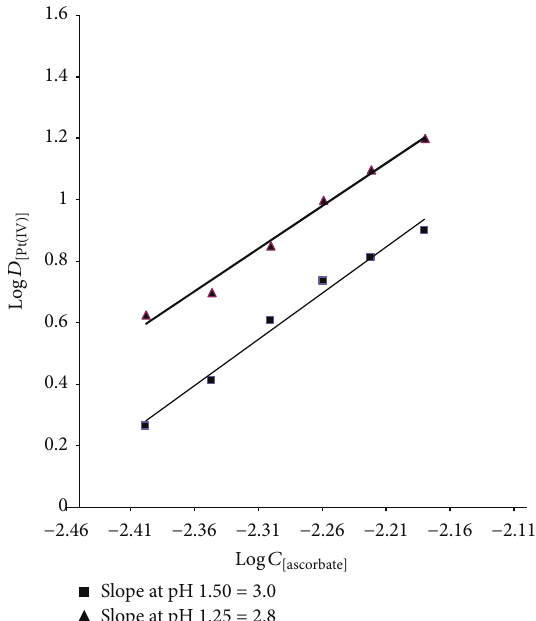
Table 3: Extraction of platinum(IV) as a function of aqueous to